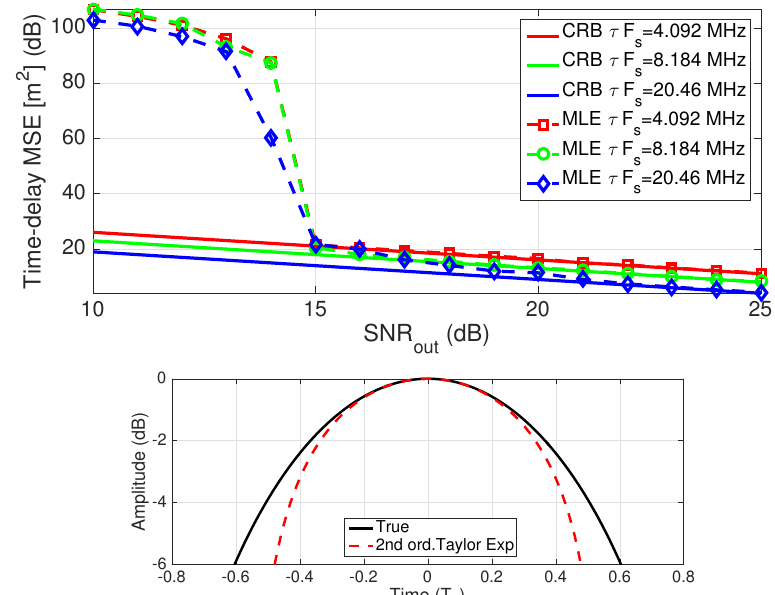
Figure 1. ( Top ) Time-delay Cramér–Rao bound (CRB) and maximum likelihood estimator (MLE) for the GPS L1 C/A PRN code (synthetic signal experiment); ( Bottom ) ambiguity function and the corresponding 2nd order Taylor expansion for the time-delay estimation of a GPS L1 C/A PRN code (synthetic signal experiment), with F s = 1/ T s = 1.023 MHz (chip